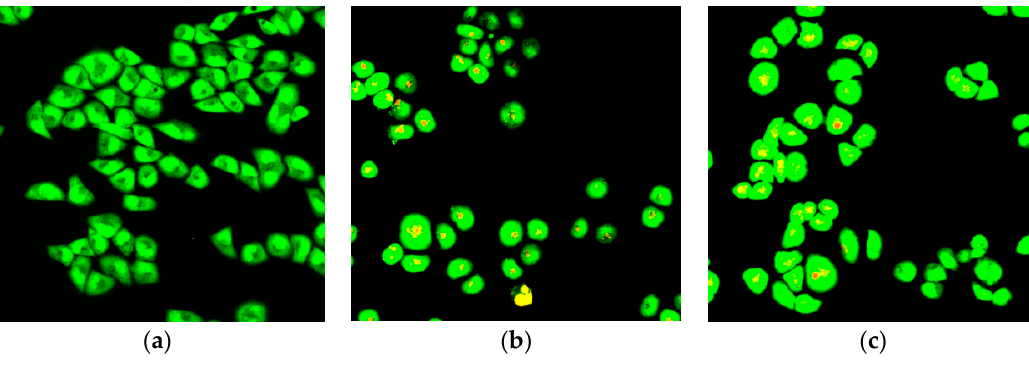
Figure 2. Acridine orange(AO)/ethidium bromide(EB) staining of compound 4u in HeLa cells. ( a ) Cells that were not treated with compound 4u were used as a control for 24 h; ( b , c ) cells that were treated with compound 4u (10 µM) for 12 and 24 h, respectively. The eyepiece was working at 20×.